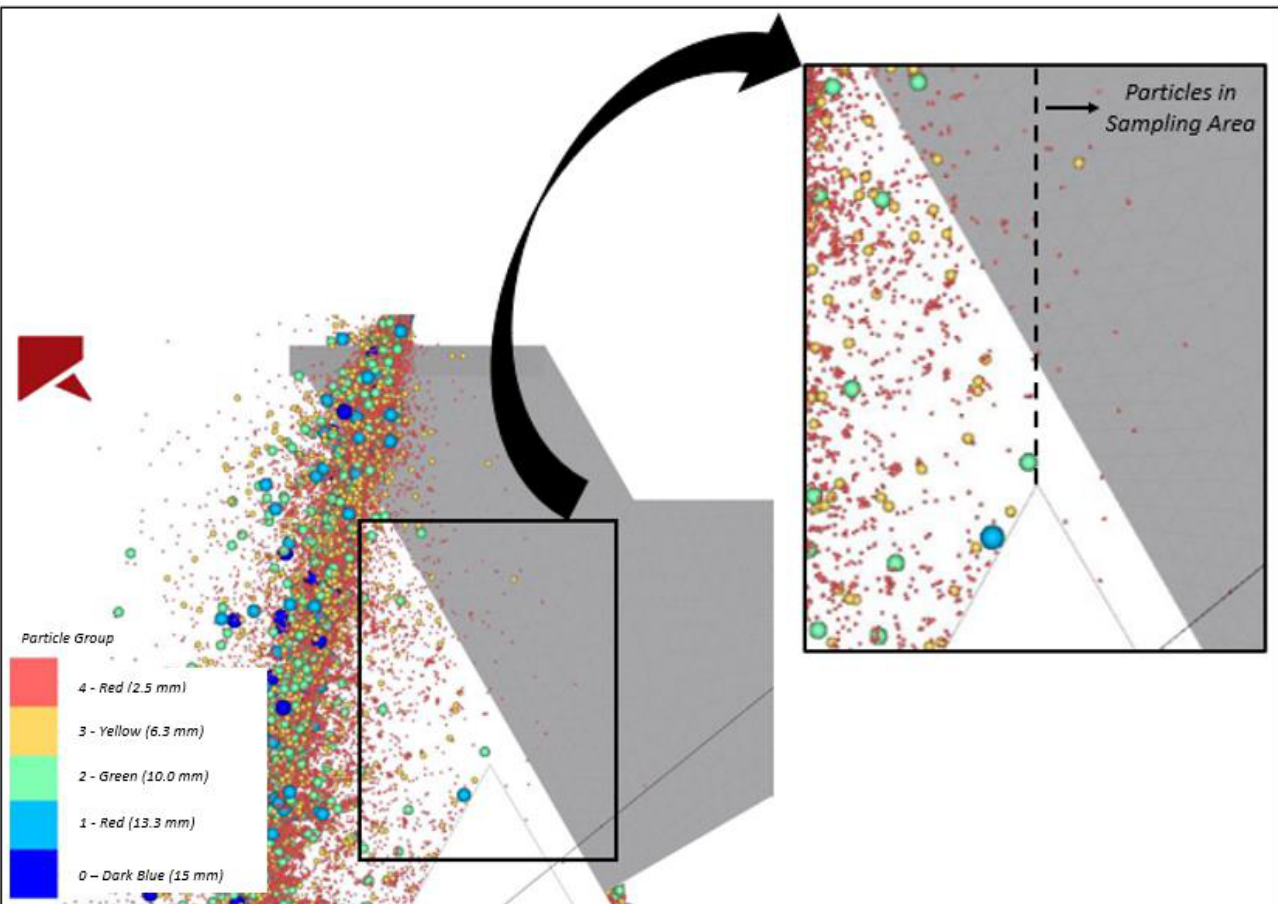
Figure 12. Snapshot of DEM simulations showing particles being dragged to the sample, coloured by particle size, with red being smallest (2.5 mm) and blue largest (15 mm).